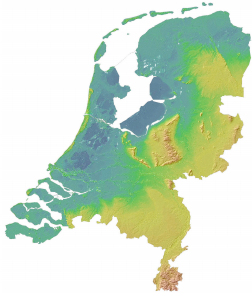
Figure 2: AHN data of the Netherlands which was completed in